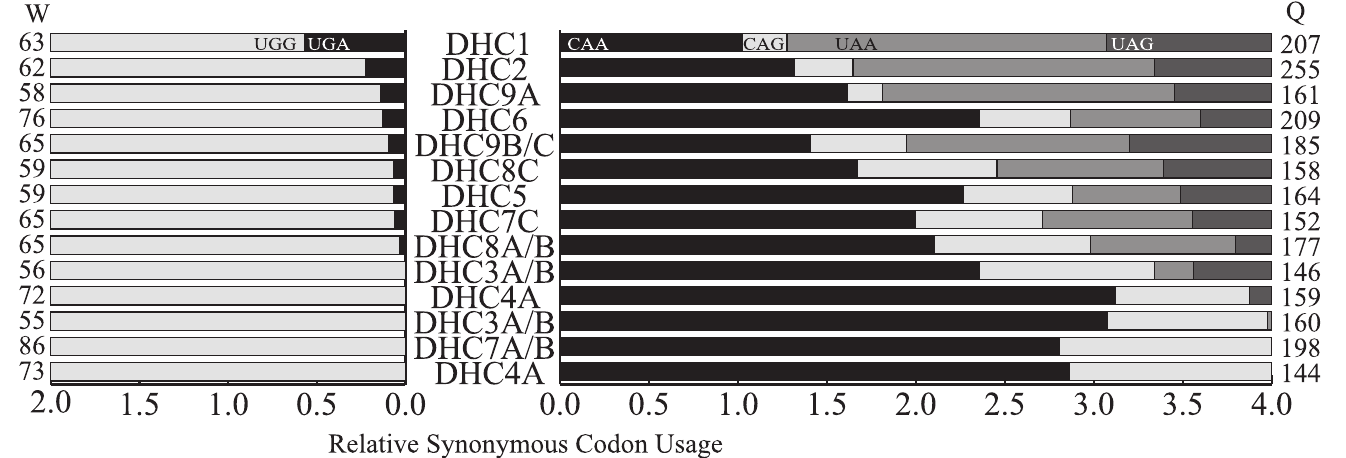
Fig 5. Tryptophan and glutamine codons in the dynein heavy chain alignments. The relative synonymous codon usage based on UGG and UGA as the two codons for tryptophan (W) on the left and the four likely glutamine (Q) codons CAA, CAG, UAA, and UAG on the right were inferred from aligned regions of Dynein Heavy Chain (DHC) family members (as shown in Table 2) based on top tBLASTx hits. The total number of tryptophan or glutamine residues in the aligned regions is shown at the end of the bars for each gene.